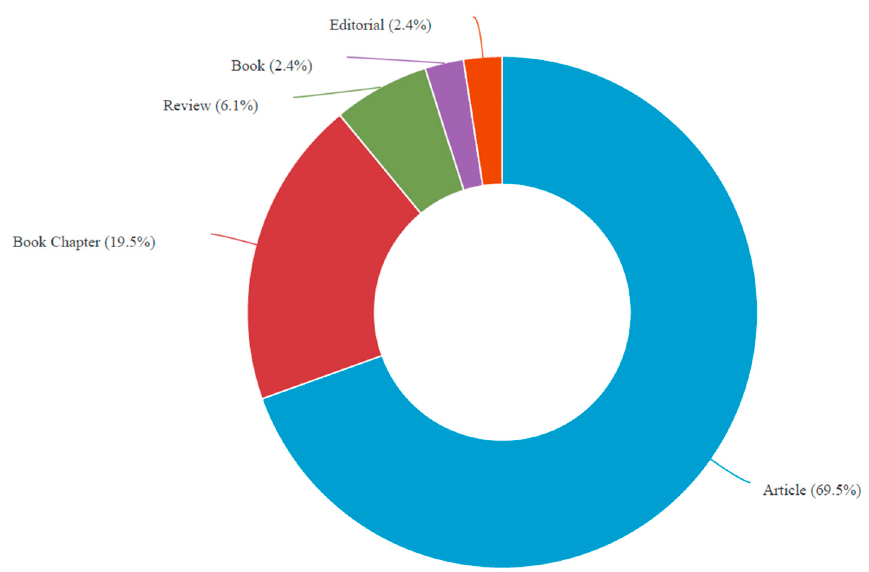
Figure 7. Self-initiated expatriation documents by type. Source: Data obtained from Scopus (August 2022).